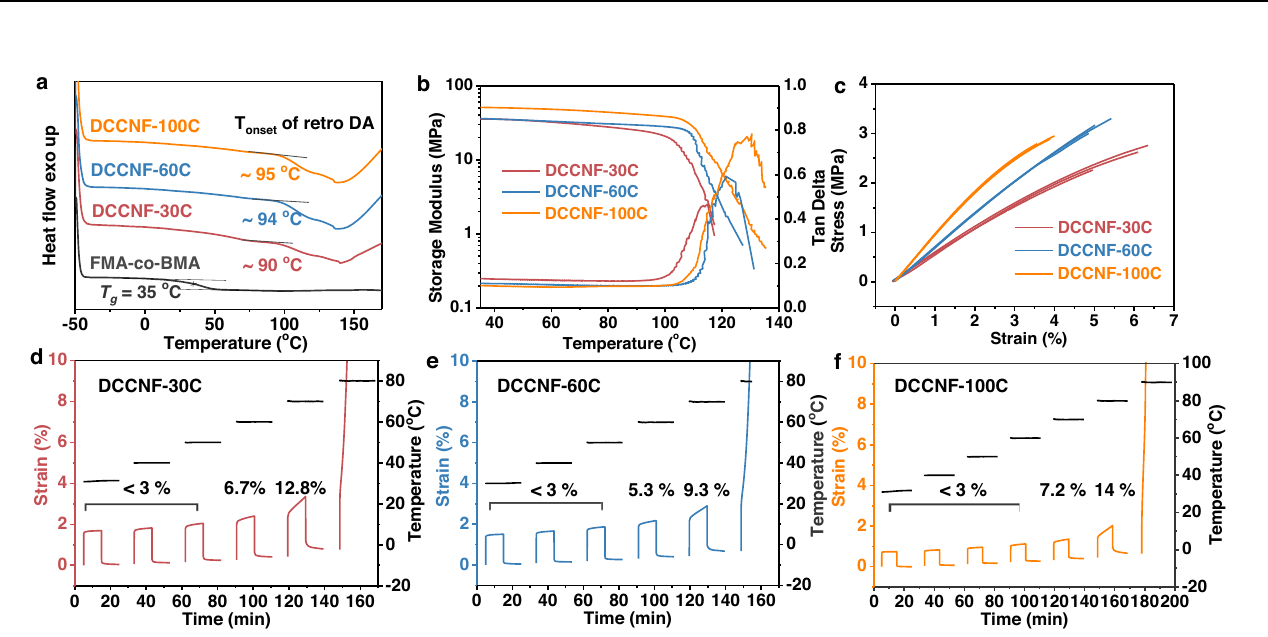
Fig. 3 | Morphology of DCCNFs. a – c FESEM images of A) DCCNF-30C, B) DCCNF- 60C, and C) DCCNF-100C, with 5K and 30K magni fi cations; d – f The statistical distribution and average fi ber diameters (d av ) of D) DCCNF-30C, ( e ) DCCNF-60C,